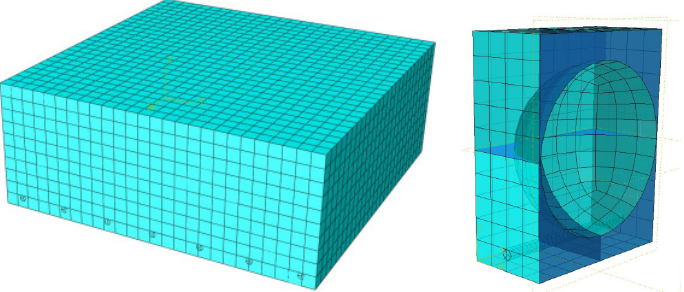
Figure 9. Left: Mesh of the solid slab with the following features: Mesh size: 38 mm; Element shape: Hex. Right: Mesh of the hollow sphere slab with the following features: Mesh size: 38 mm; Element shape: Hex.